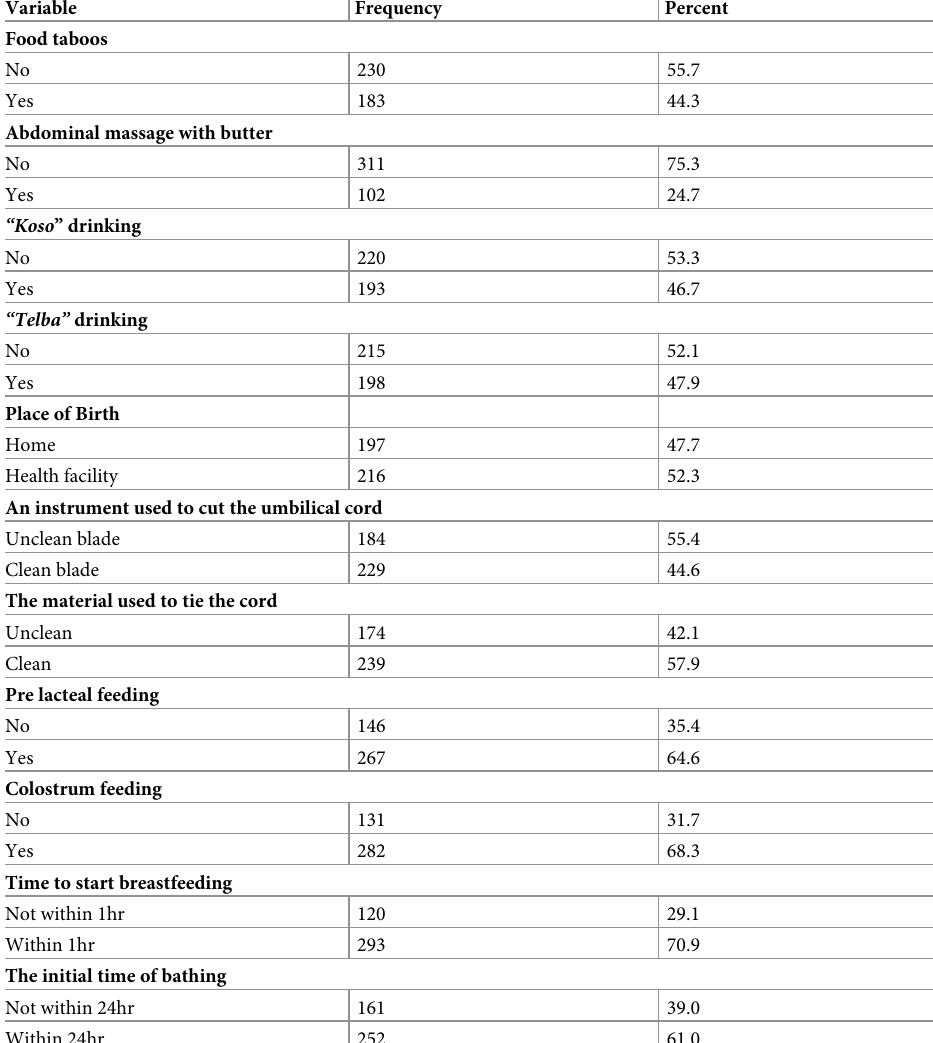
Table 2. Harmful cultural practices during the perinatal period in Southern Ethiopia, 2019 (n =